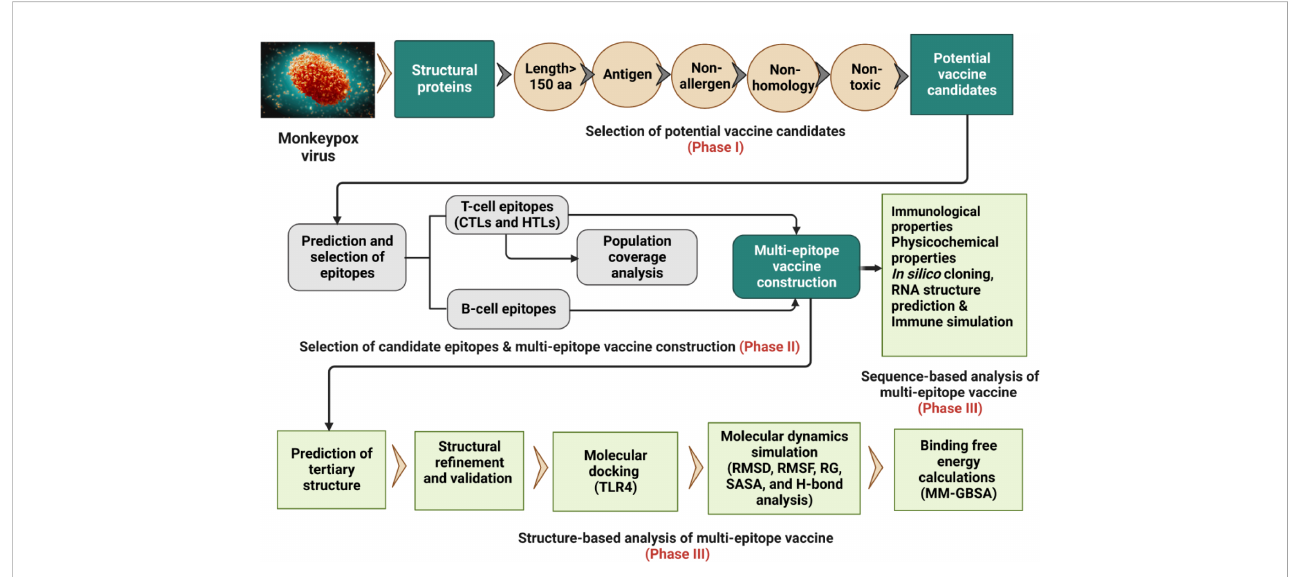
FIGURE 1 Schematic representation of the research pipeline implemented in this study.to design a multi-epitope vaccine construct for the